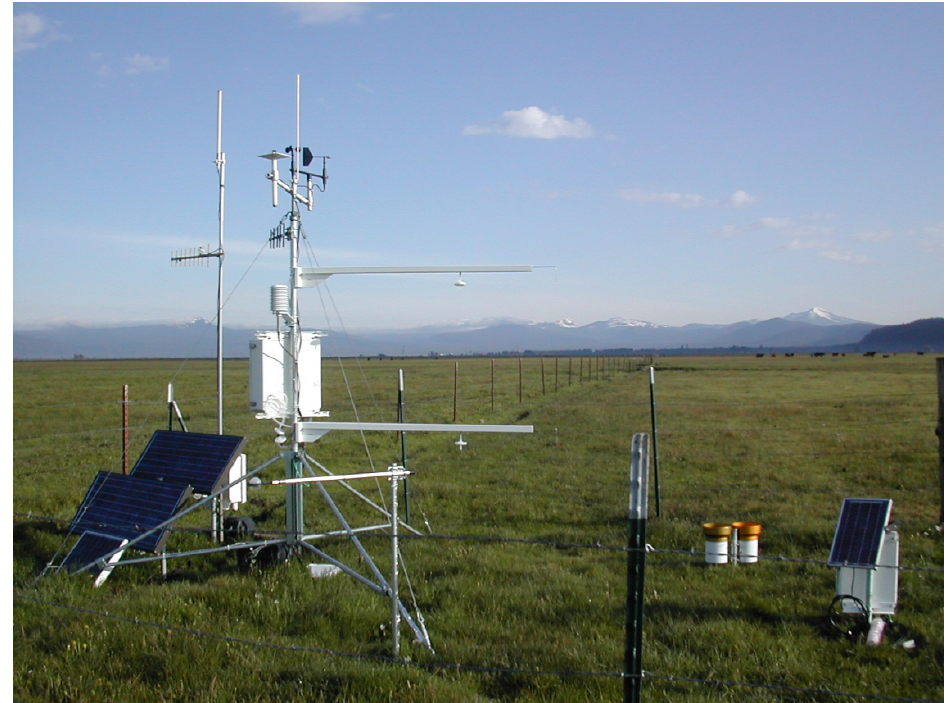
Figure 2. Bowen ratio installation at KL03 (unirrigated) site, Thomas Ranch, April